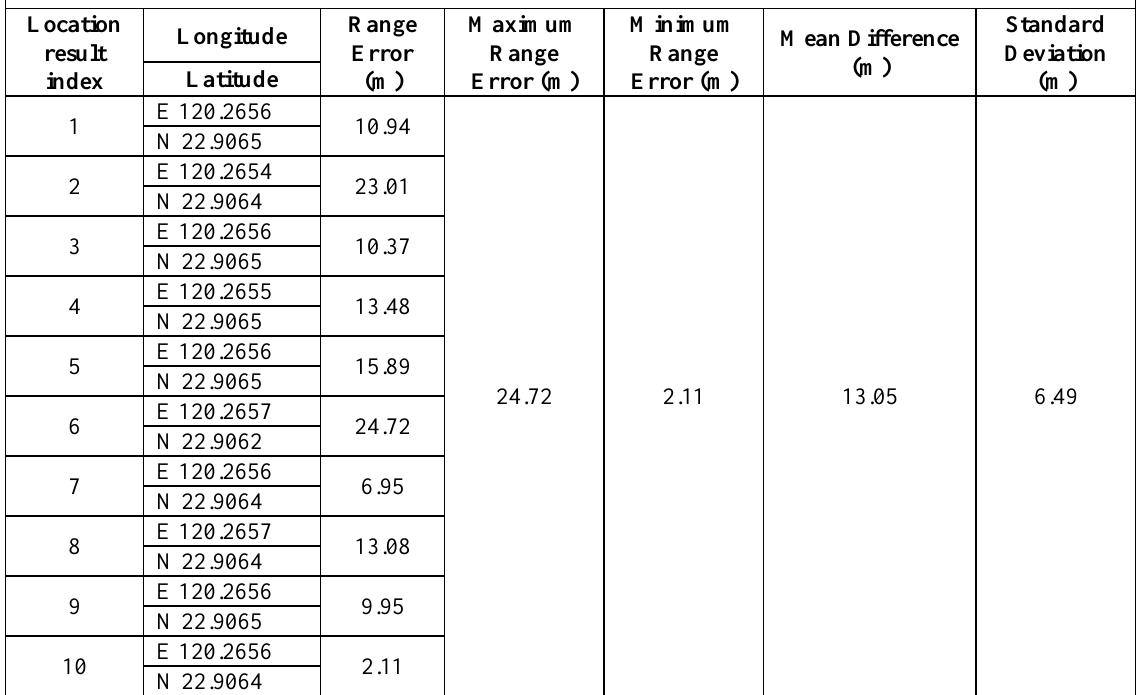
Table 3. The location performance using the proposed genetic algorithm for the measured 88.3 MHz broadcasting station.